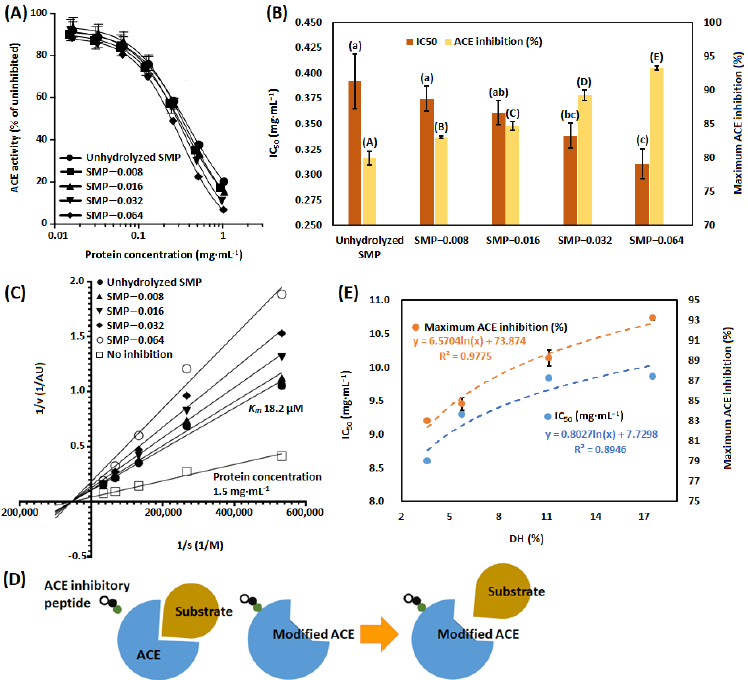
Figure 3. Uninhibited ACE activity (%) of unhydrolyzed and papain-hydrolyzed SMP ( A ). IC 50 and maximum ACE inhibition (%) of unhydrolyzed and papain-hydrolyzed SMP ( B ). The Lineweaver–Burk plot of unhydrolyzed and papain-hydrolyzed SMP ( C ). The mechanism of ACE inhibition by peptide ( D ). Anti-angiotensin activity of papain-hydrolyzed SMP with respect of DH (%) ( E ). Results are presented by mean value with standard deviation (± values). The dissimilar alphabet in superscript represents the significant difference between results, evaluated by the Tukey’s post hoc method.